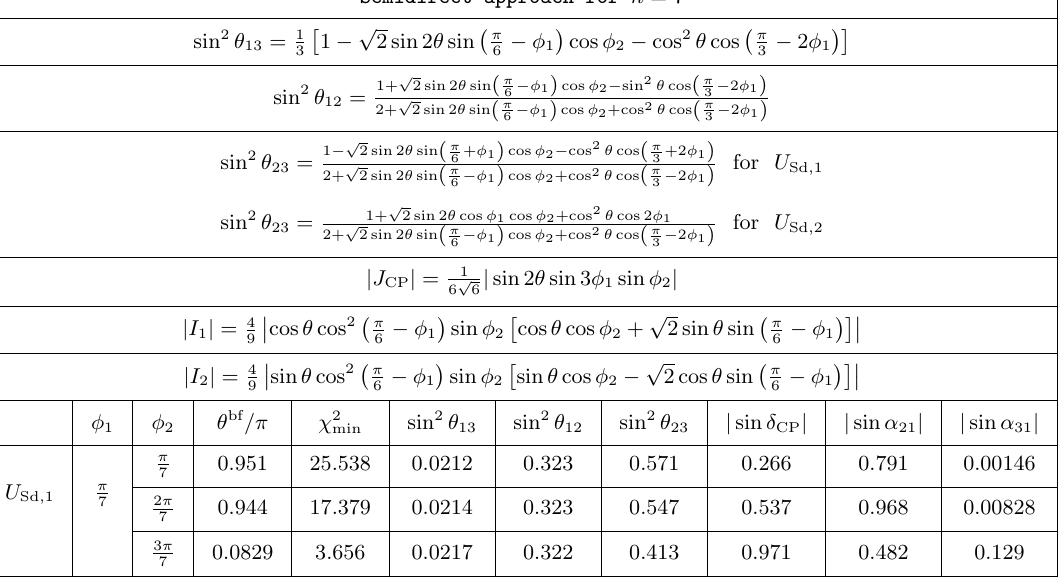
Table 12 . Results of the lepton mixing parameters for the viable cases obtained from the (cid:1)(294) (cid:13)avor group in the semidirect approach [56]. All values of sin 2 (cid:18) ij , j sin (cid:14) CP j , j sin (cid:11) 21 j and j sin (cid:11) 31 j are obtained at the best (cid:12)tting points (cid:18) = (cid:18) bf under the assumption of NH neutrino spectrum, and similar results are obtained for IH spectrum. Since the PMNS matrix U Sd has the property U Sd ( (cid:30) 1 ; (cid:25) (cid:0) (cid:30) 2 ; (cid:18) ) = U (cid:3) ( (cid:30) 1 ; (cid:30) 2 ; (cid:25) (cid:0) (cid:18) ) diag(1 ; 1 ; (cid:0) 1), hence we only show the results for 0 (cid:20) (cid:30) 2 < (cid:25)= Sd